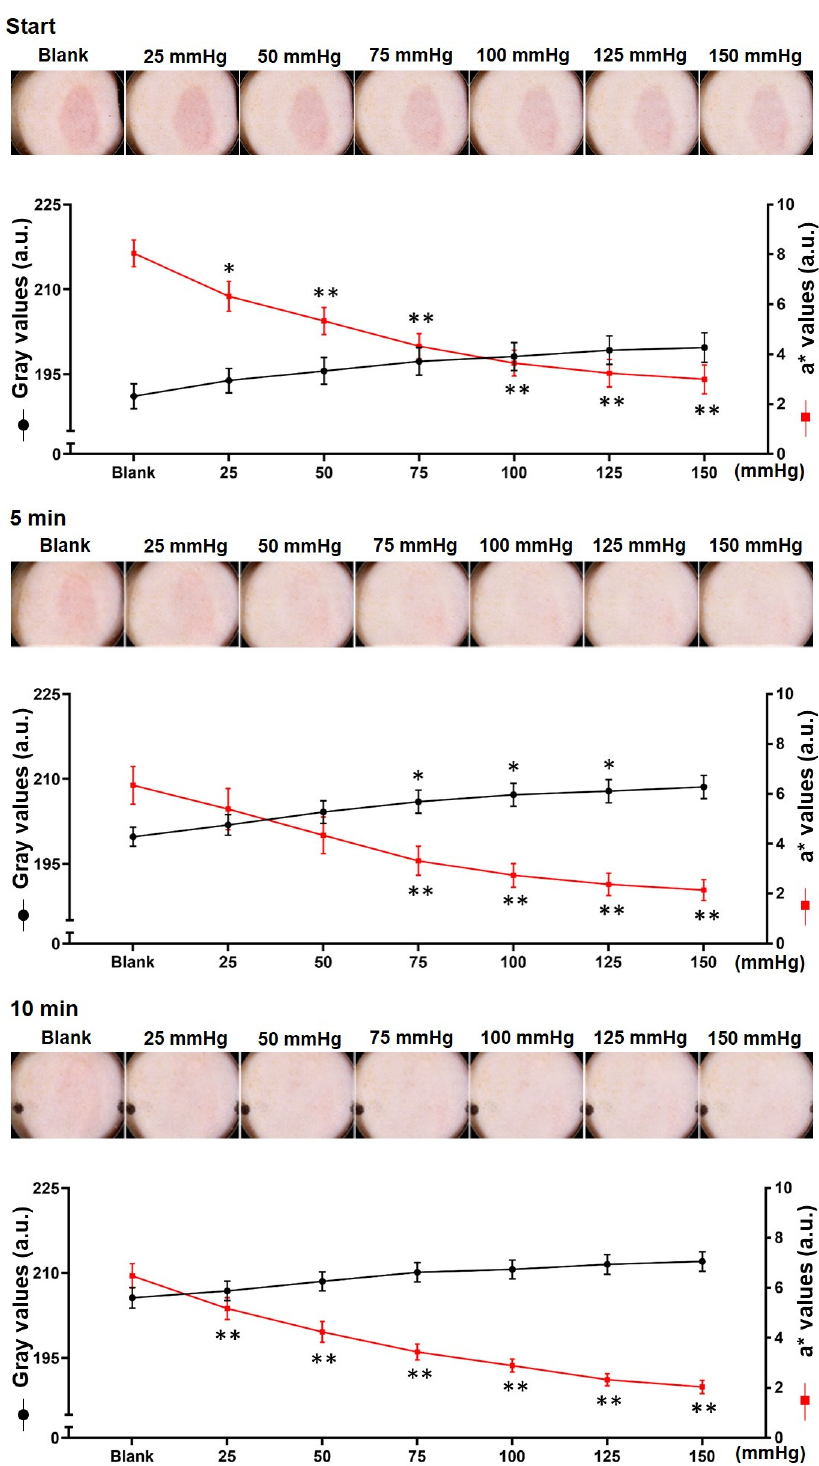
Figure 2. Macroscopic observations and quantification of blanchable erythema. Macroscopic observations of the loaded area at the start ( top panel ) and, 5 ( middle panel ) and 10 min ( bottom panel ) after decompression. The pressure range of the transparent disc method was from blank to 150 mmHg. Representative pictures are shown at the top of each panel. The blanchable erythema area (gray value) was quantified using the Image J software and the erythema index was regarded as a* value measured by the spectrophotometer. (bottom; n = 8 for each group; * p < 0.05, ** p < 0.01 vs. blank via 1-way ANOVA and Dunnett’s post hoc test). Black color indicates the gray value; red color indicates the erythema